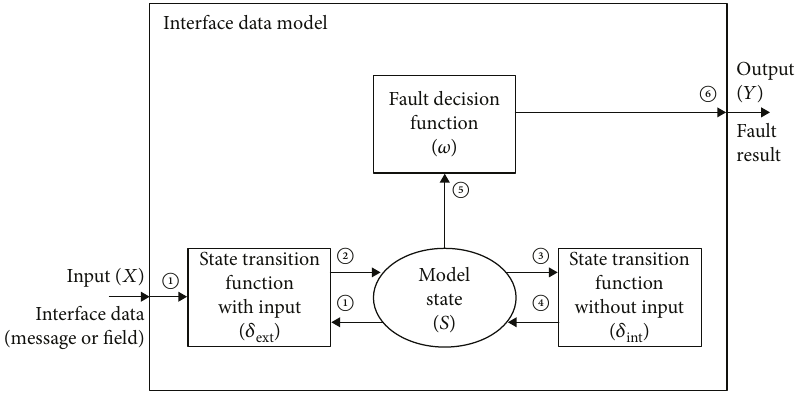
Figure 4: Elements of proposed interface data